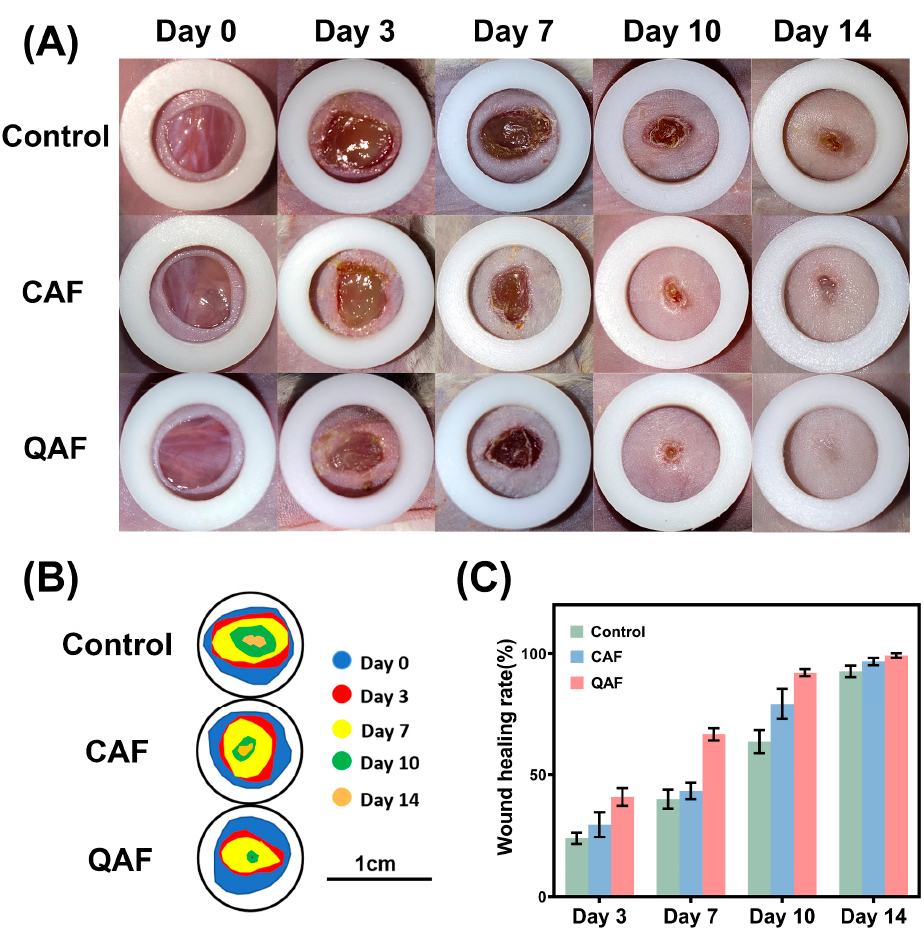
Figure 7. ( A ) Images of the wound healing sites on days 0, 3, 7, 10 and 14; ( B ) Traces of wound-bed closure on days 0, 3, 7, 10 and 14. ( C ) Quantitative analysis of wound healing rates according to Figure 7 ( A ) ( n =